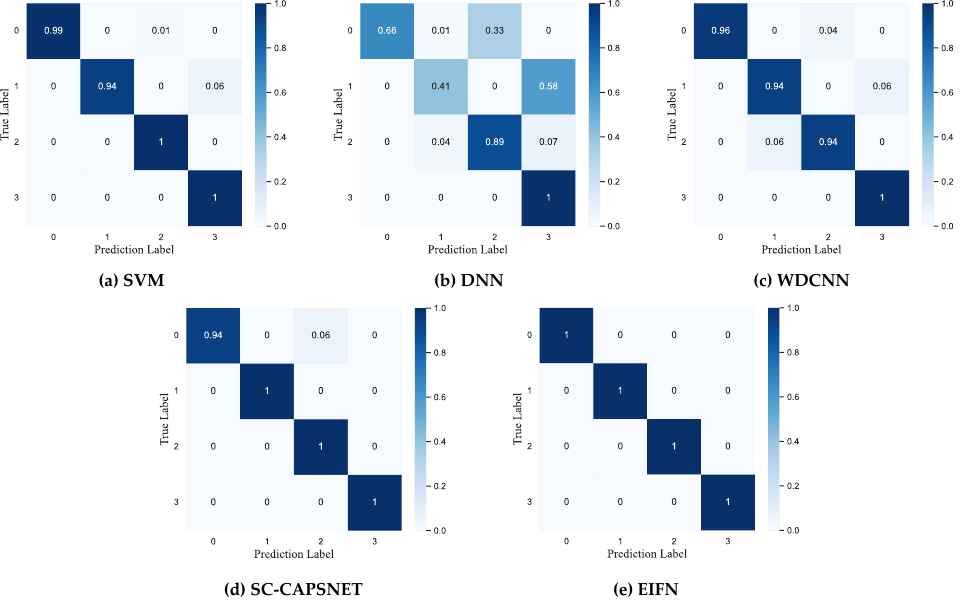
Figure 10. The result of bearing fault diagnosis on IMS. The figure contains two indicators: preci- sion and recall.